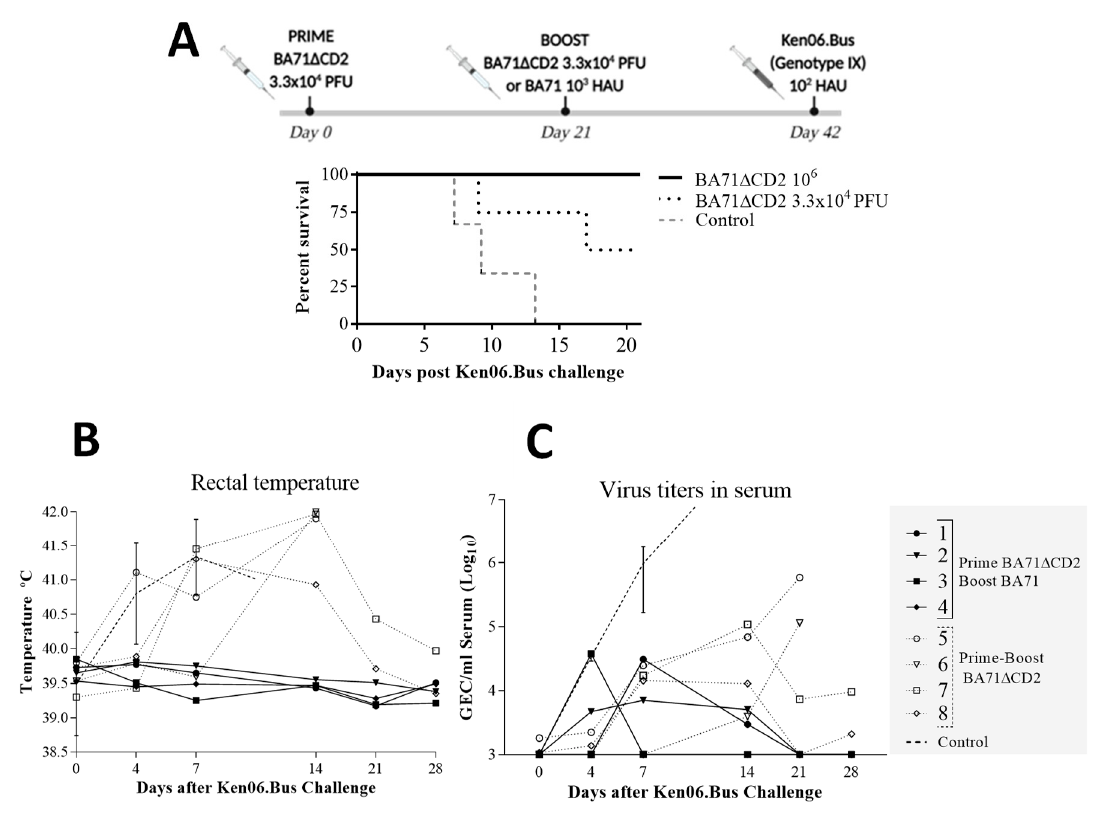
Figure 2. ( A ) Schematic representation the in vivo experimental design with survival rates observed after Ken06.Bus challenge and comparison of the kinetics of ( B ) fever and ( C ) ASFV load in serum, after Ken06.Bus challenge. Data plotted in panels B and C correspond to individual animals inoculated with BA71 ∆ CD2 and boosted with either BA71 (black lines) or BA71 ∆ CD2 (dotted lines). Average and standard deviation values obtained from control animals are also depicted (dashed line). Virus titers are plotted on a logarithmic scale as genome equivalent copies (GEC) per milliliter of serum, being 1 GEC/µL serum the limit of detection of the assay.